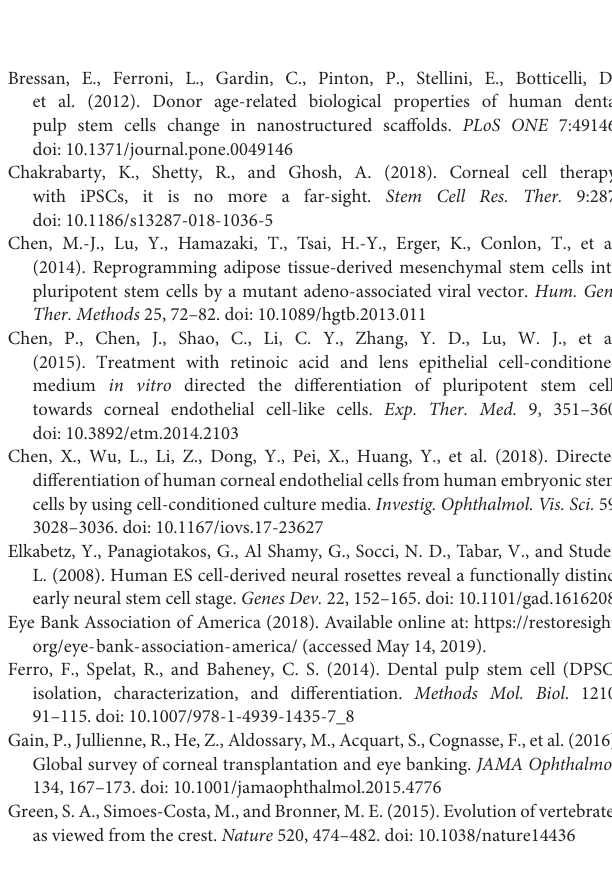
Supplementary Figure 1 | Protein analysis of iPSC-derived from DPSC. Immunofluorescence stained images for reprogrammed cells from DPSC. Cells were positive for the pluripotent markers Oct4 (A-red), SSEA4 (A-green), TRA-1-60 (B-red), and Sox2 (B-green). Blue color corresponds to nucleus (DAPI). Scale bars: 100 µ m. Supplementary Figure 2 | Protein analysis of NCSC-derived from DPSC at day 4 of culture. Immunofluorescence stained images for dedifferentiated cells from DPSC. Neurospheres cells were positive for the NCSC markers p75. Blue color corresponds to nucleus (DAPI). Scale bar: 100 µ